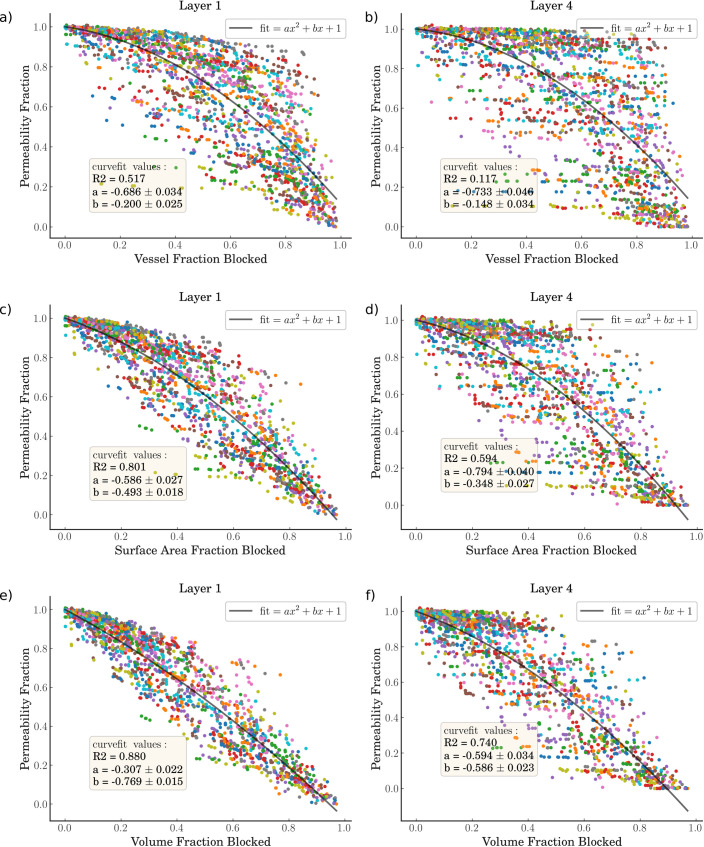
a,b) The fractional drop in permeability against the fraction of vessels blocked where a) is in the top layer of the voxel and b) is the middle layer. c,d) The fractional drop in permeability against the fraction of vessel surface area blocked where c) is in the top layer of the voxel and d) is the middle layer. e,f) The fractional drop in permeability against the fraction of vessel volume blocked where e) is in the top layer of the voxel and f) is the middle layer. The middle layer is at a depth of 1.25–1.67mm. A line of best fit is plotted in black, with the fit equation in the top right corner of each graph, with the bottom left of the graph giving the coefficients of the line of best fit and the R2 goodness-of-fit metric.